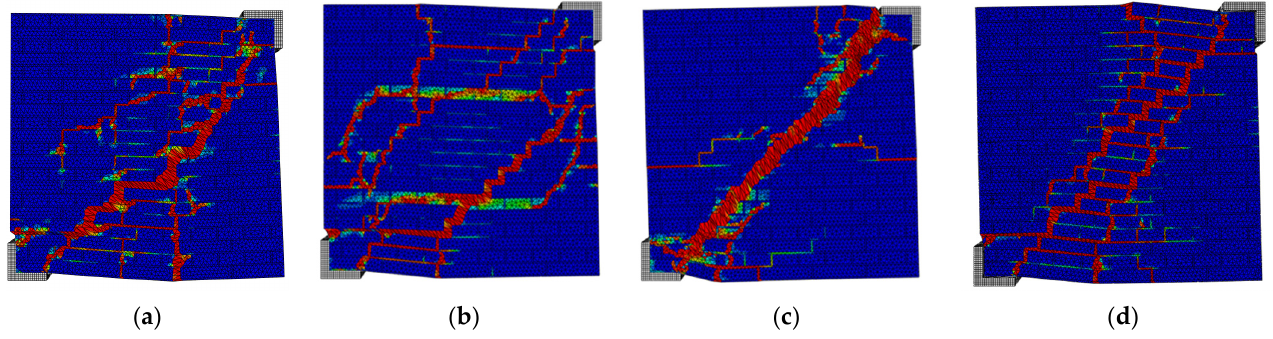
Figure 15. Damage of tension at failure for different weak-brick patterns: ( a ) R1 pattern, ( b ) R2 pattern, ( c ) R3 pattern, ( d ) no weak bricks.